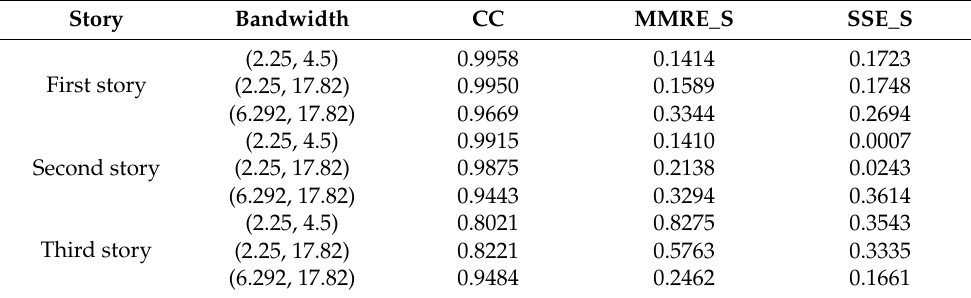
Table 5. Error comparison of PA versus smartphone for the undamaged case.